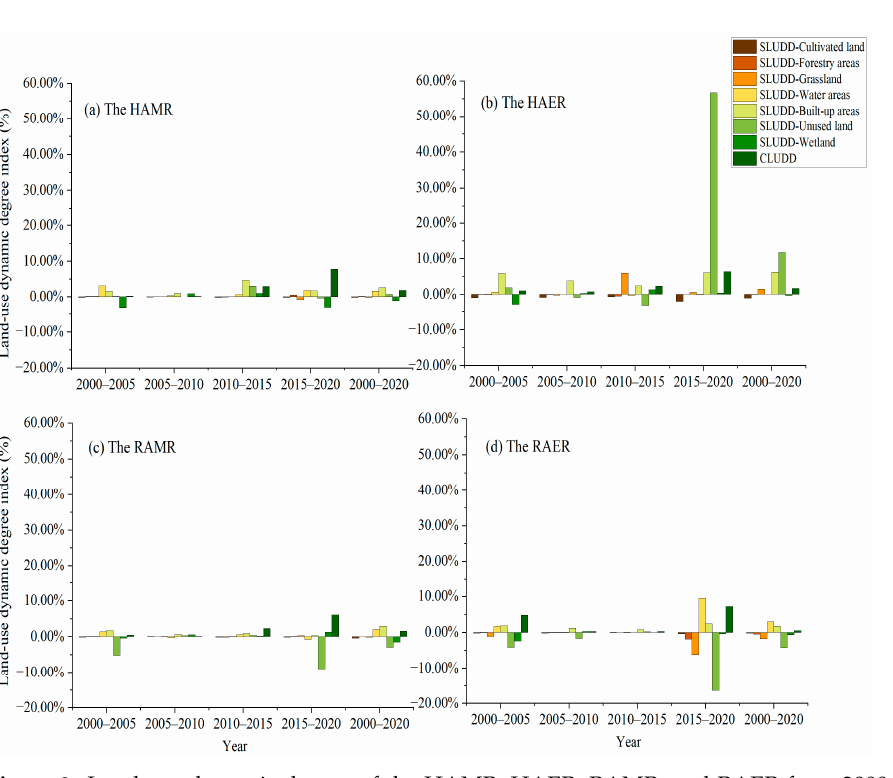
Figure 2. Land use dynamic degree of the HAMR, HAER, RAMR, and RAER from 2000 to 2020. ( a ) Land use dynamic degree of the HAMR, ( b ) Land use dynamic degree of the HAER, ( c ) Land use dynamic degree of the RAMR, ( d ) Land use dynamic degree of the RAER.